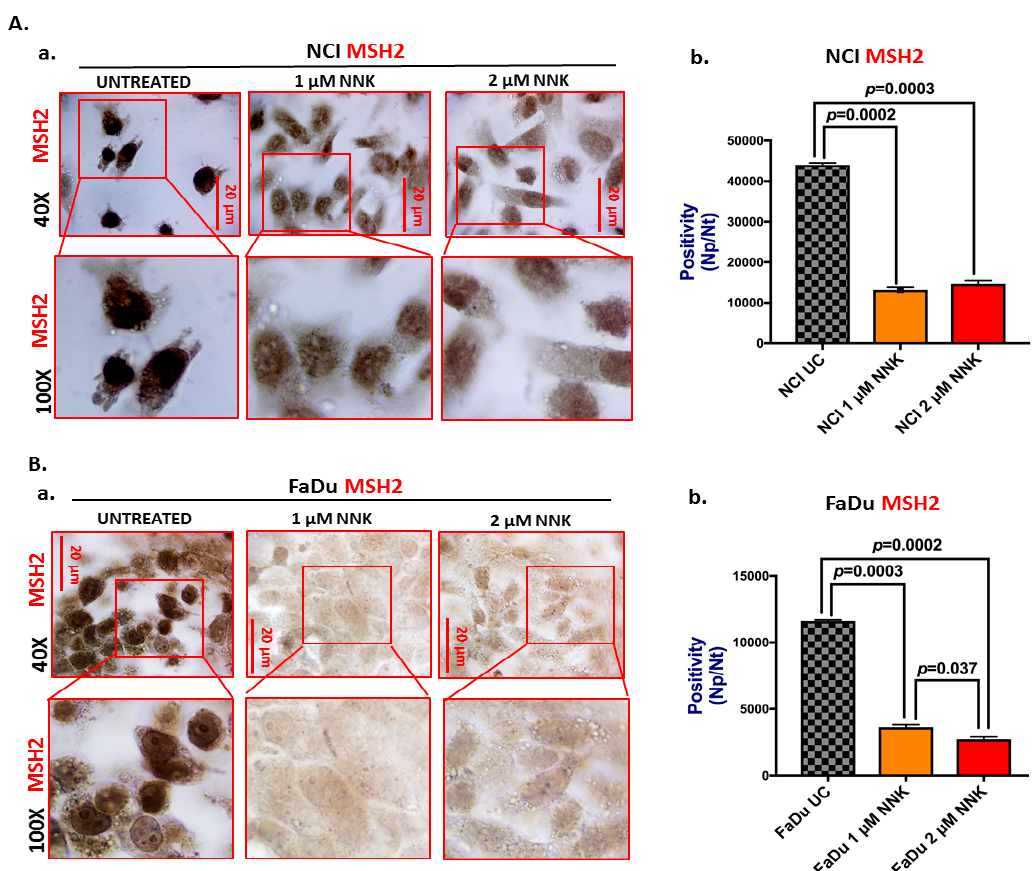
Figure 1. Either low or high dose of NNK reduces MSH2 expression in both lung (NCI) and head and neck (FaDu) cancer cells. Immunoperoxidase cell staining for MSH2 reveals that ( A ) NCI and ( B ) FaDU exposed to either 1 µ M or 2 µ M of NNK produce reduced MSH2 nuclear levels, as indicated by ( A - a and B - a ) the less intense MSH2 staining (scale bar: 20 µ m), and ( A - b and B - b ) the significantly lower nuclear MSH2 levels [Np / Nt = Number of nuclear positive / total number of nuclei, means(SD)], compared to untreated controls. Data were obtained from two independent images ( ≥ 10 cells) ( p values by t -test; multiple comparisons by Holm-Sidak; GraphPad Prism 7.0). Images were captured using Aperio CS2 and analyzed by Image Scope software (Leica Microsystems, Bu ff alo Grove,